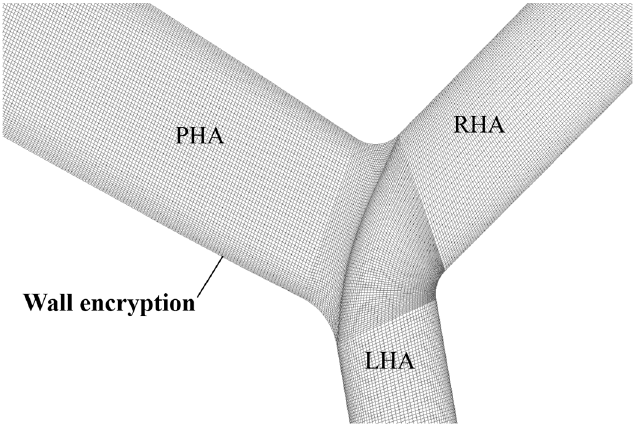
Figure 2. Illustration of the computational mesh near the RHA and LHA bifurcation.